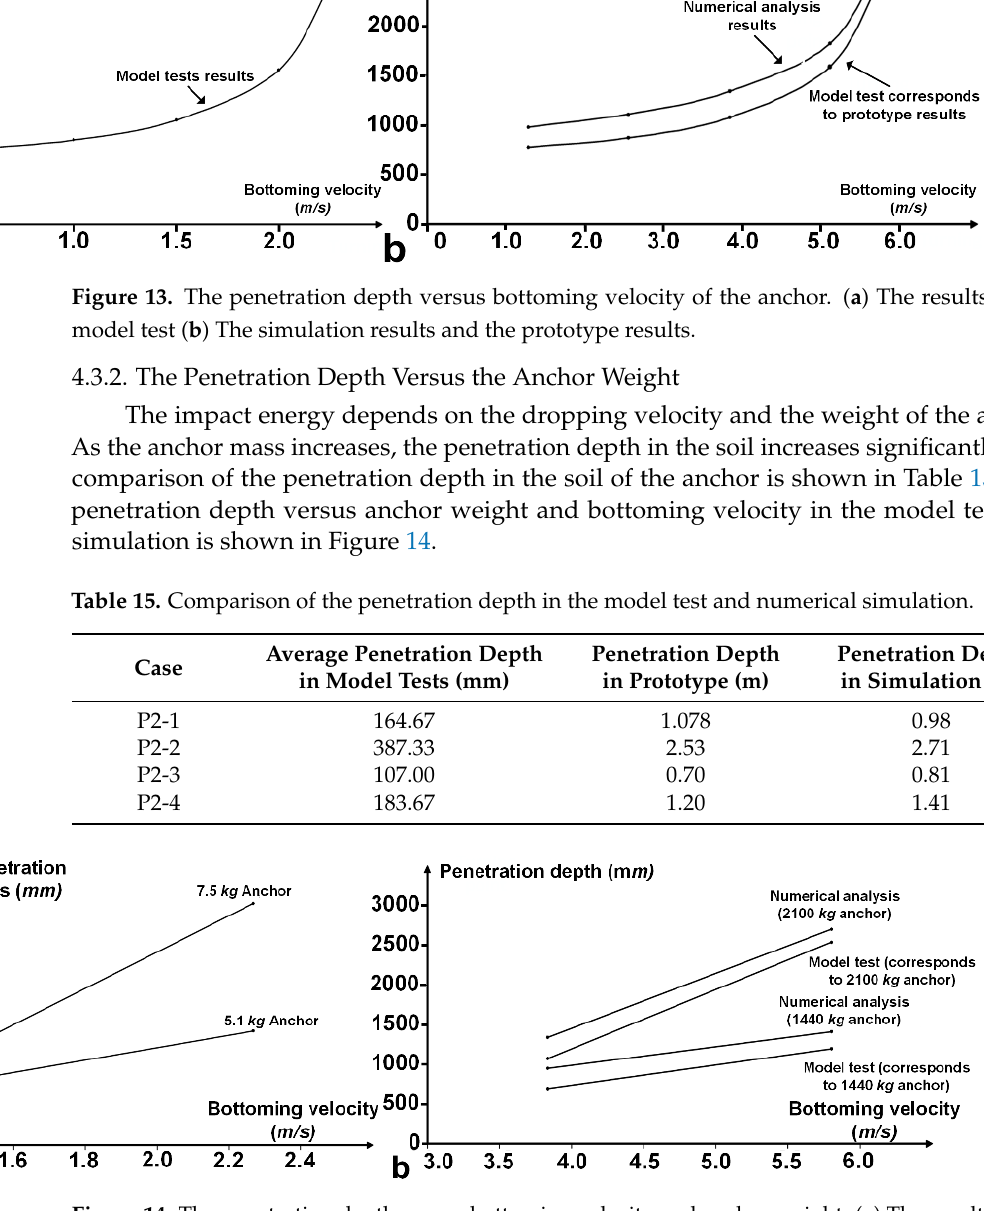
Figure 13. The penetration depth versus bottoming velocity of the anchor. ( a ) The results in the model test ( b ) The simulation results and the prototype results.